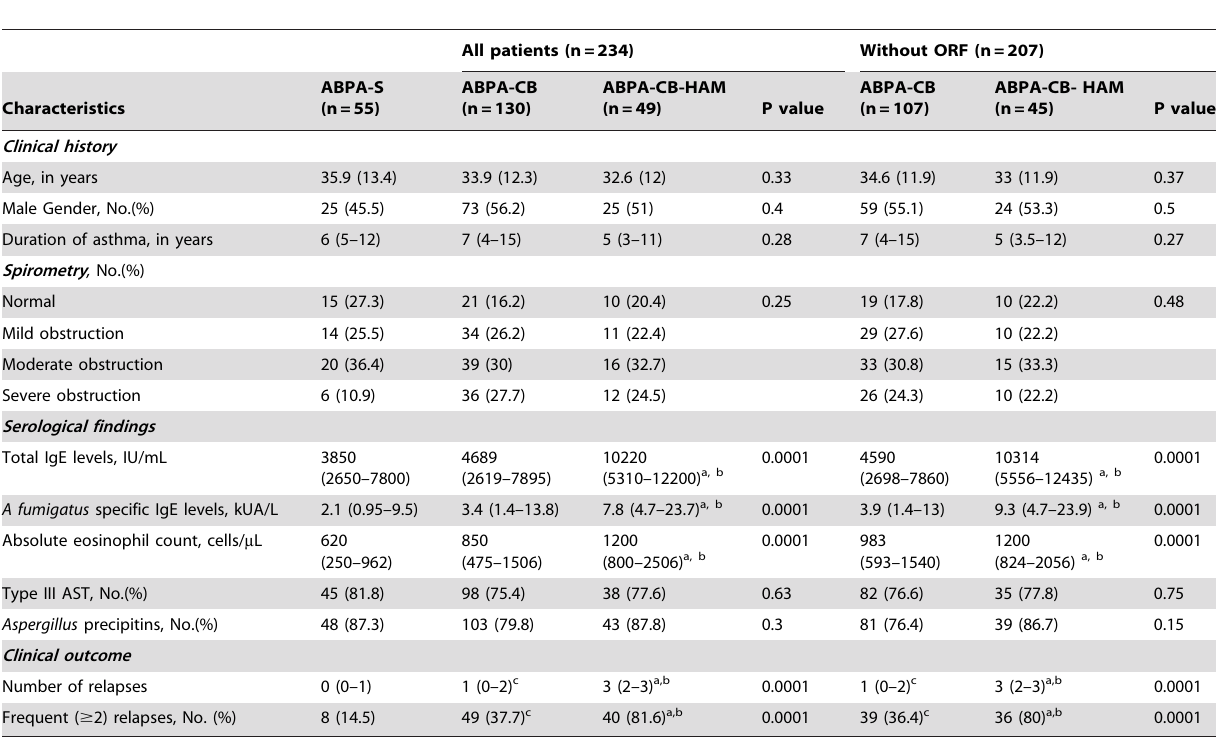
Table 4. Clinical, spirometric, serological differences and outcomes in patients with allergic bronchopulmonary aspergillosis (ABPA) based on the proposed staging on the basis of high attenuation mucus (HAM) with and without the presence of other radiologic findings (ORF).